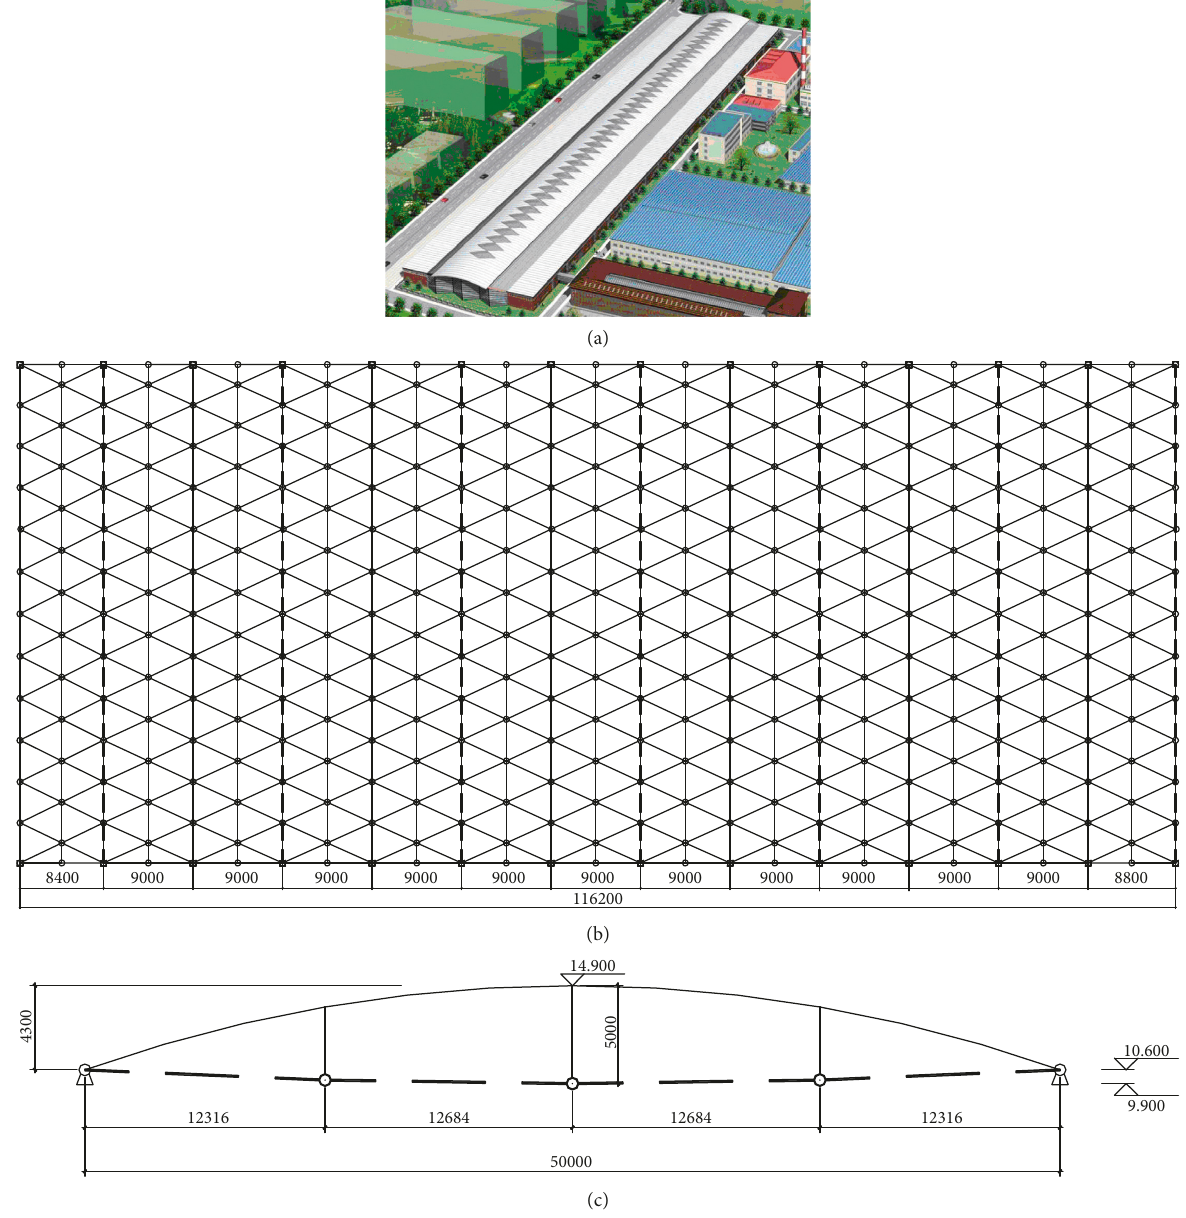
Figure 1: Elevation and plane graph of the CSBV structure. (a) Building perspective. (b) Plane graph of the CSBV (units: mm). (c) Elevation of the CSBV (units: Table 1: Modulus of elasticity and thermal expansion coefficient of the four types of cables. Types